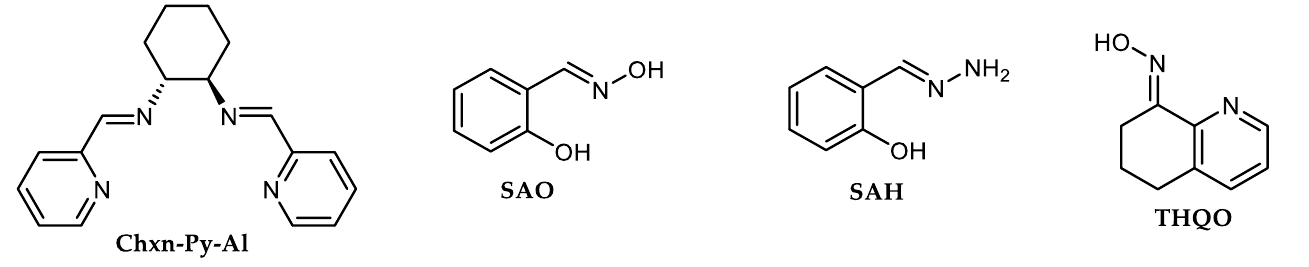
Figure 3. Imine, oxime or hydrazone-based ligands applicable for the production of air-stable Cu-catalysts [14,35,46,63–65].